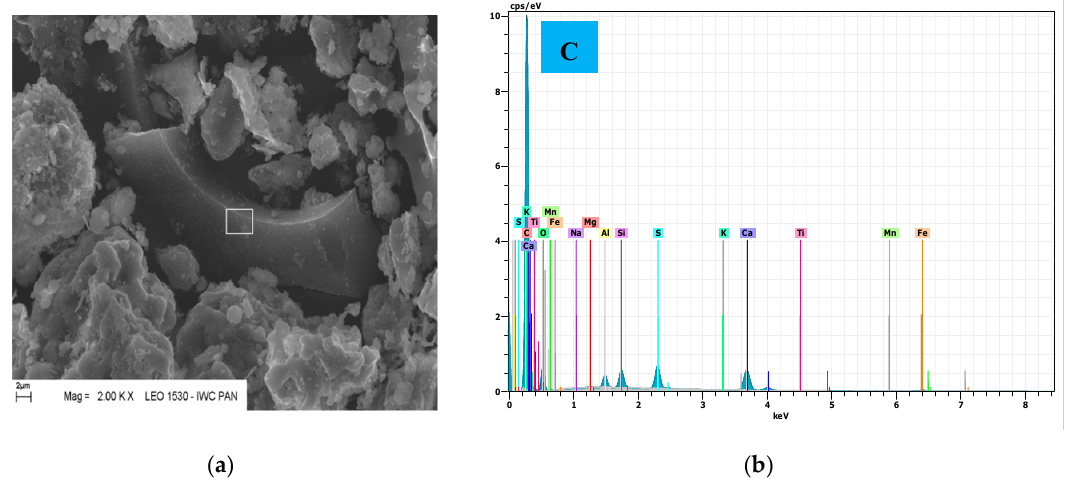
Figure 2. Microstructure of CFBC fly ash grain with visible unburned coal particle ( a ) and analysis in microarea ( b ); magnification 20,000 × , scale bar = 2 µ m.